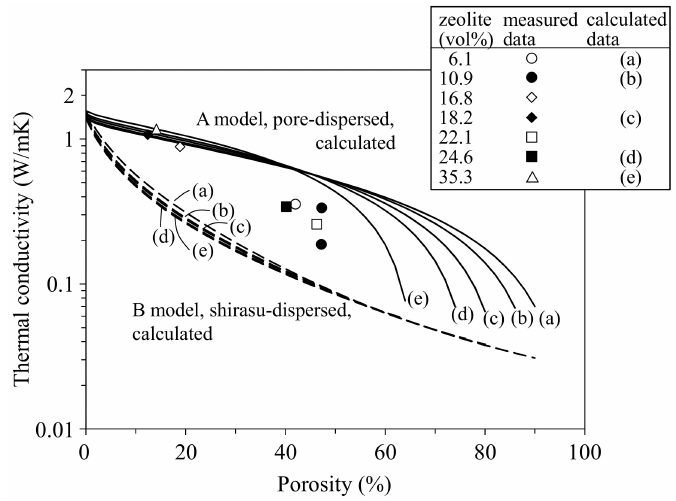
Figure 7. Relationship between the thermal conductivity and porosity for the mordenite zeolite– pore–shirasu glass